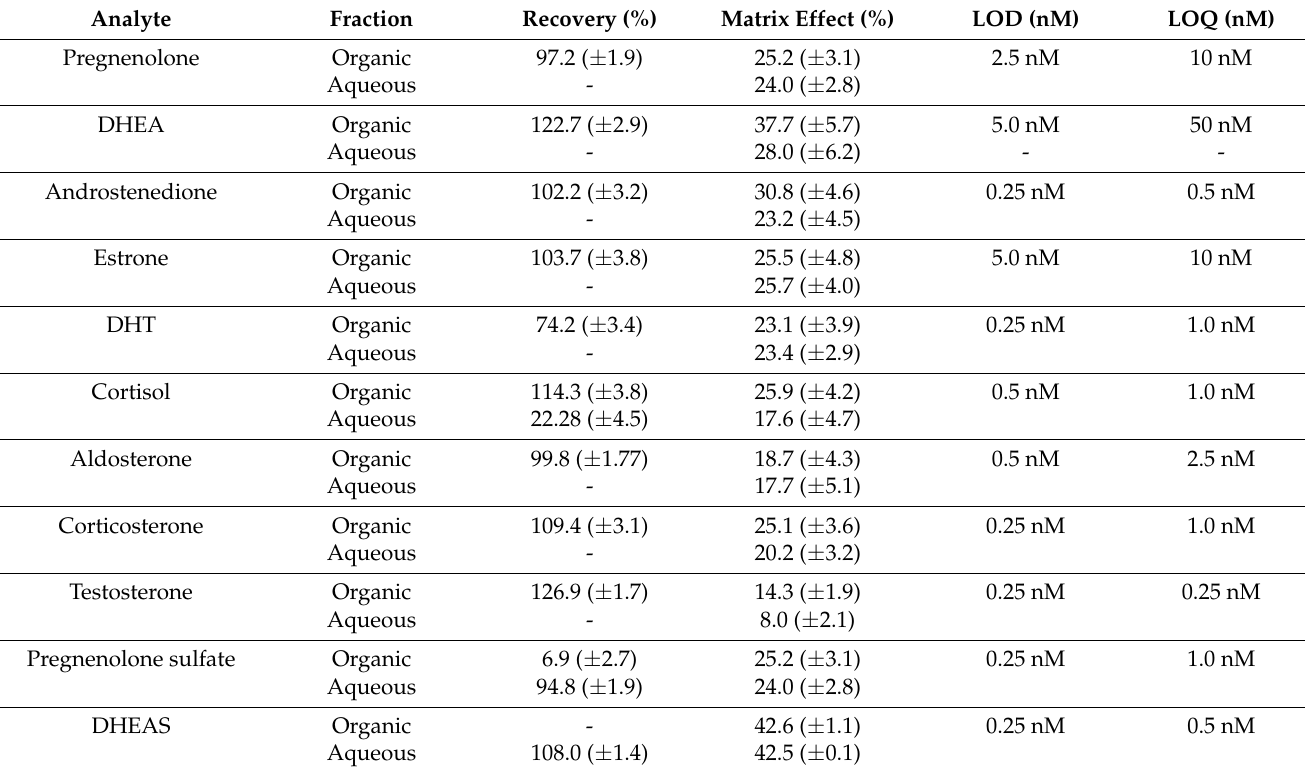
Table 1. Summary of the optimized method characteristics. The recoveries ( ± standard deviation) and matrix effect as signal loss ( ± standard deviation) of the extraction procedure in two different biological matrices ( n = 6; biological matrix: DU145 cell) are reported. In addition, LOD and LOQ values of the analytes in the adequate fraction are compiled. LOD: Limit of detection; LOQ: Limit of